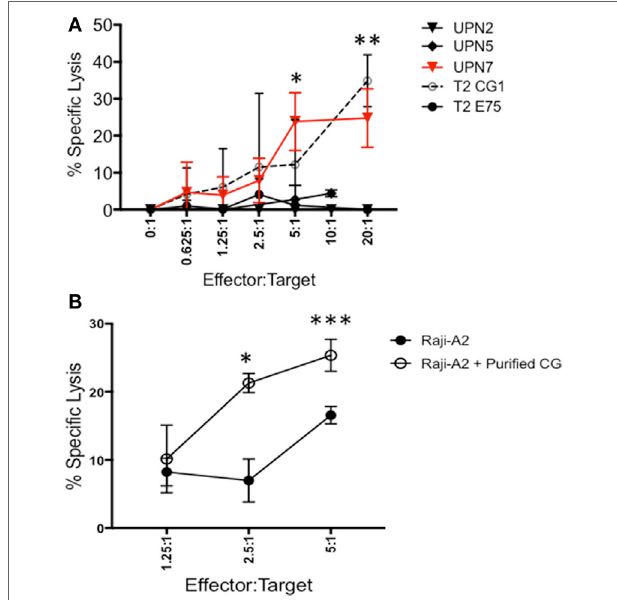
FigUre 4 | ALL shows susceptibility to killing by CG1-cytotoxic T lymphocytes (CTLs). Patient samples (UPN2, UPN5 and UPN7), T2 cells, and Raji-A2 cells were loaded with calcein-AM, and then cocultured with CG1-CTLs for 4 h at various E (effector): T (target) ratios. Cytotoxicity was determined by measurement of intracellular calcein-AM in live cells. T2 cell lines were pulsed with CG1 and E75 peptide as positive and negative controls, respectively. (a) UPN7, which endogenously expresses Cathepsin G (CG), and (B) Raji-A2 pulsed with purified CG protein (see Figure S5 in Supplementary Material) showed increased killing by CG1-CTL. Cytotoxicity data are means ± SEM from triplicate wells from a representative experiment. * P < 0.05; ** P < 0.01; ***P < 0.001.